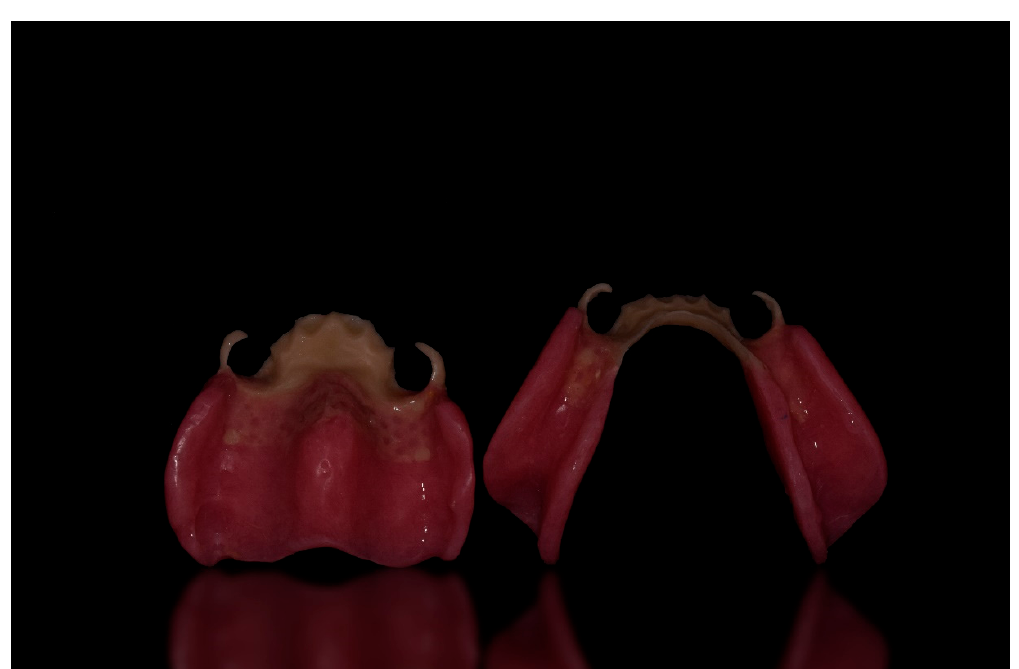
Figure 5. Intaglio surface of acetal frameworks with processed acrylic resin after finishing and polishing. The frameworks were designed with meshes and finish lines to provide mechanical retention between the acetal and acrylic resin.